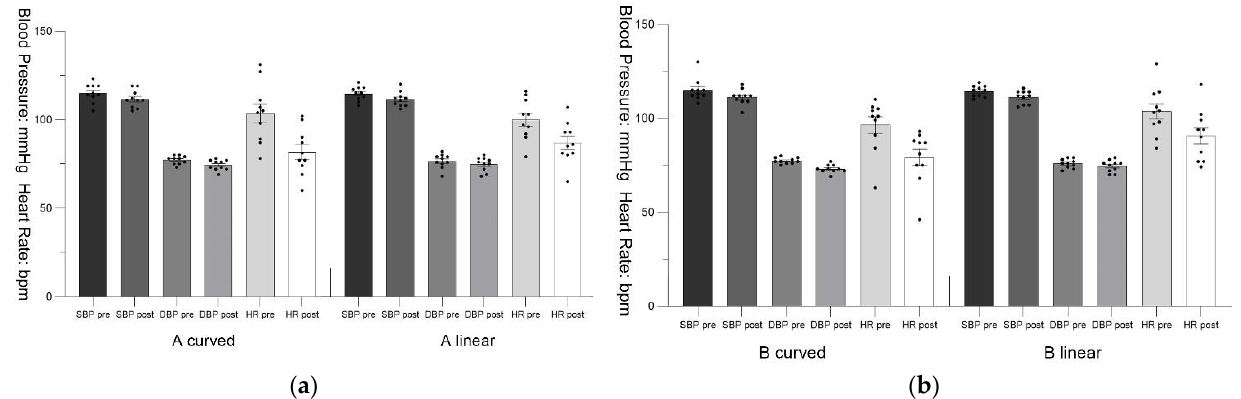
Figure 5. Pre-test and post-test of blood pressure and heart rate with the standard error mean bars: